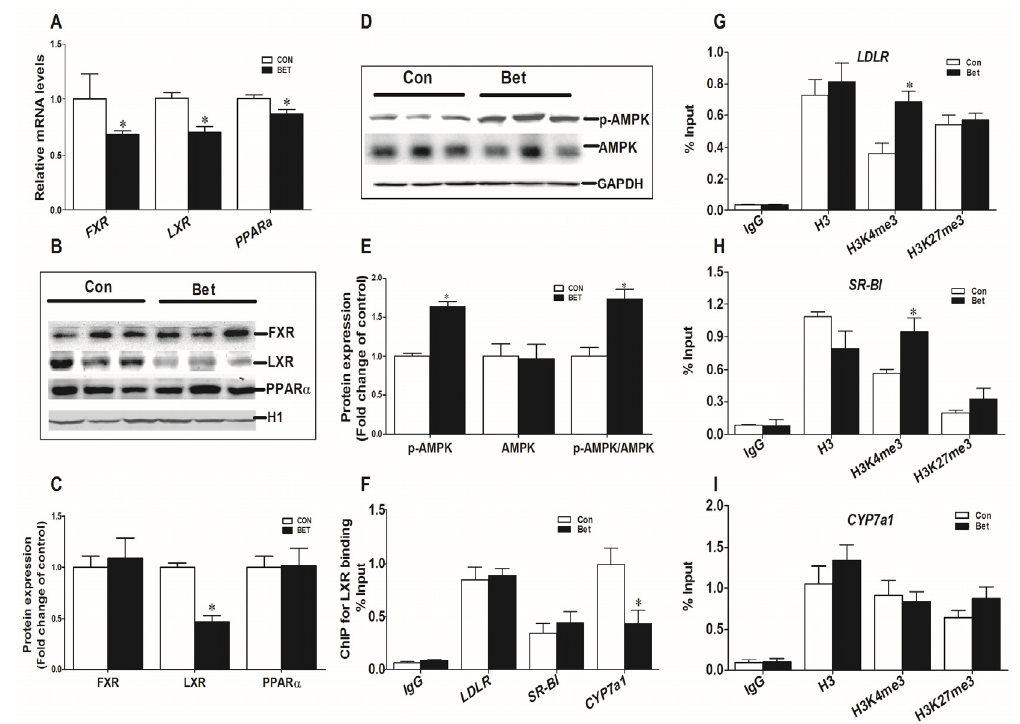
Figure 3. Hepatic mRNA abundance ( A ) and Western blotting analysis ( B , C ) of nuclear transcriptional factors farnesoid X receptor (FXR), liver X receptor (LXR), and peroxisome proliferator-activated receptor alpha (PPAR α ); ( D , E ) illustrates Western blotting analysis and graphic summary of signal protein AMP-activated protein kinase (AMPK) in the liver of weaning piglets. Chromatin immunoprecipitation (ChIP) analysis of LXR binding on low-density lipoprotein receptor (LDLR), scavenger receptor class B type I (SR-BI), and cholesterol-7 α -hydroxylase (CYP7a1) genes’ promoters ( F ); and respective ChIP analysis of histone modifications on LDLR ( G ); SR-BI ( H ); and CYP7a1 ( I ) genes’ promoters in the liver of weaning piglets. Values are means ± SEM, n = 8. Different from control, * p < 0.05.